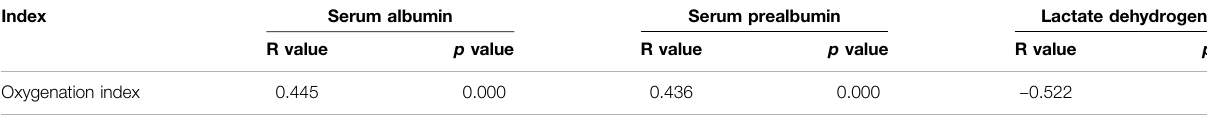
TABLE 3 | Correlation_analysis_of_serum_albumin, _prealbumin, lactate_dehydrogenase_and_oxygenation_index.